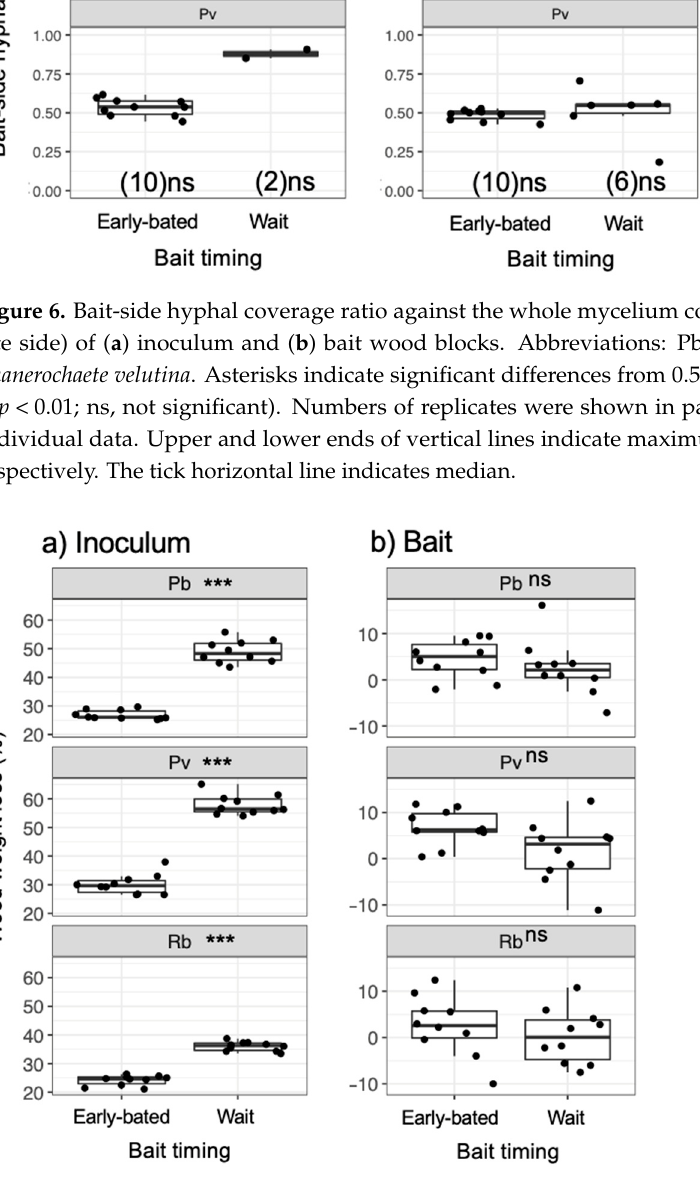
Figure 7. Weight loss of ( a ) inoculum and ( b ) bait wood blocks. Abbreviations: Pb, Pholiota brun- nescens ; Pv, Phanerochaete velutina ; Rb, Resinicium bicolor . Asterisks indicate significant differences between ‘early-baited’ and ‘wait’ experiments (Wilcoxon rank-sum test: *** p < 0.001; ns, not sig- nificant, N = 10). Balck dots are individual data. Upper and lower ends of vertical lines indicate maximum and minimum values, respectively. The tick horizontal line indicates median.